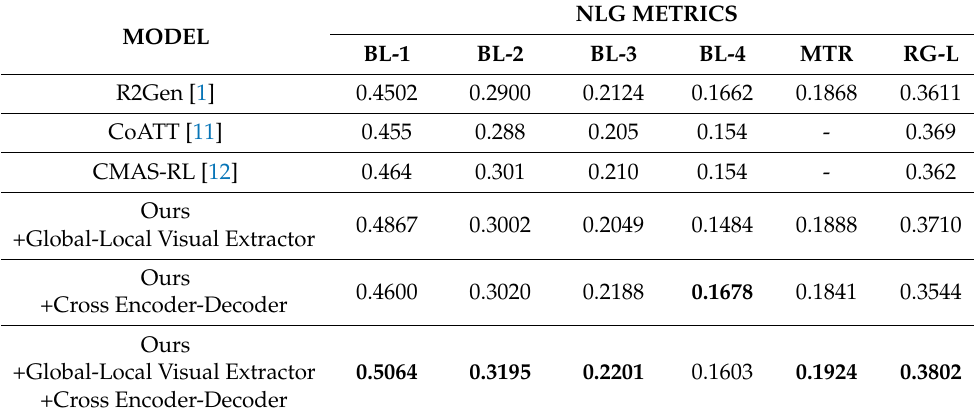
Table 2. The performance of the baseline and proposed method against the IU X-ray dataset. BL- n denotes BLEU score using up to n-grams. MTR and RG-L denote METEOR and ROUGE-L, respectively. The experiment was conducted up to 5 times by changing the seed, and the table was filled out based on the highest score. Bold it to emphasize the best score for each